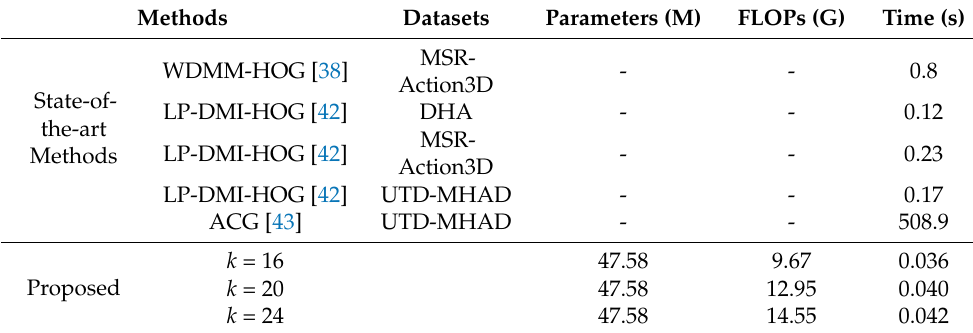
Table 3. Network complexity